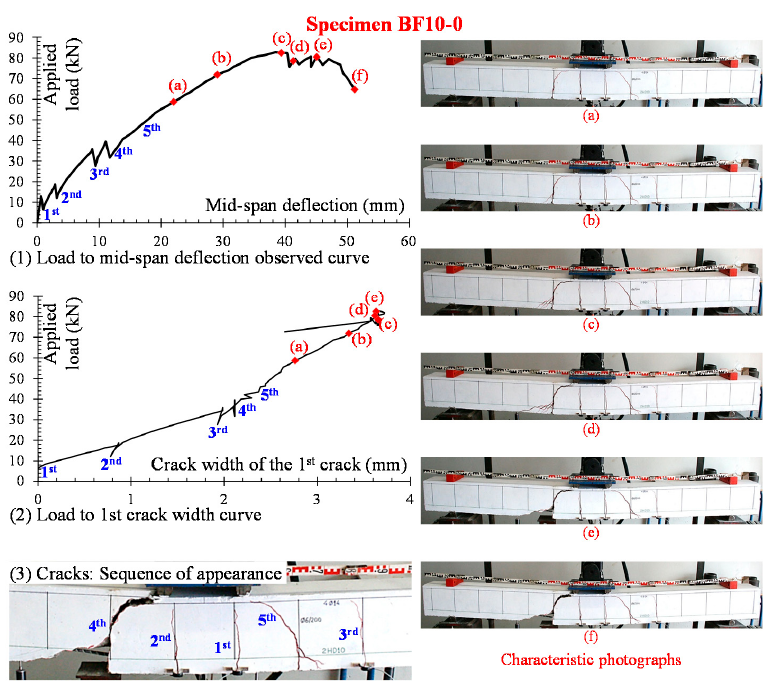
Figure 7. Beam BF10-0. Load to midspan deflection (1) and load to crack width (2) observed curves. Photographs at characteristic points ( a ) to ( f ). Sequence of appearance of the observed cracks (3).